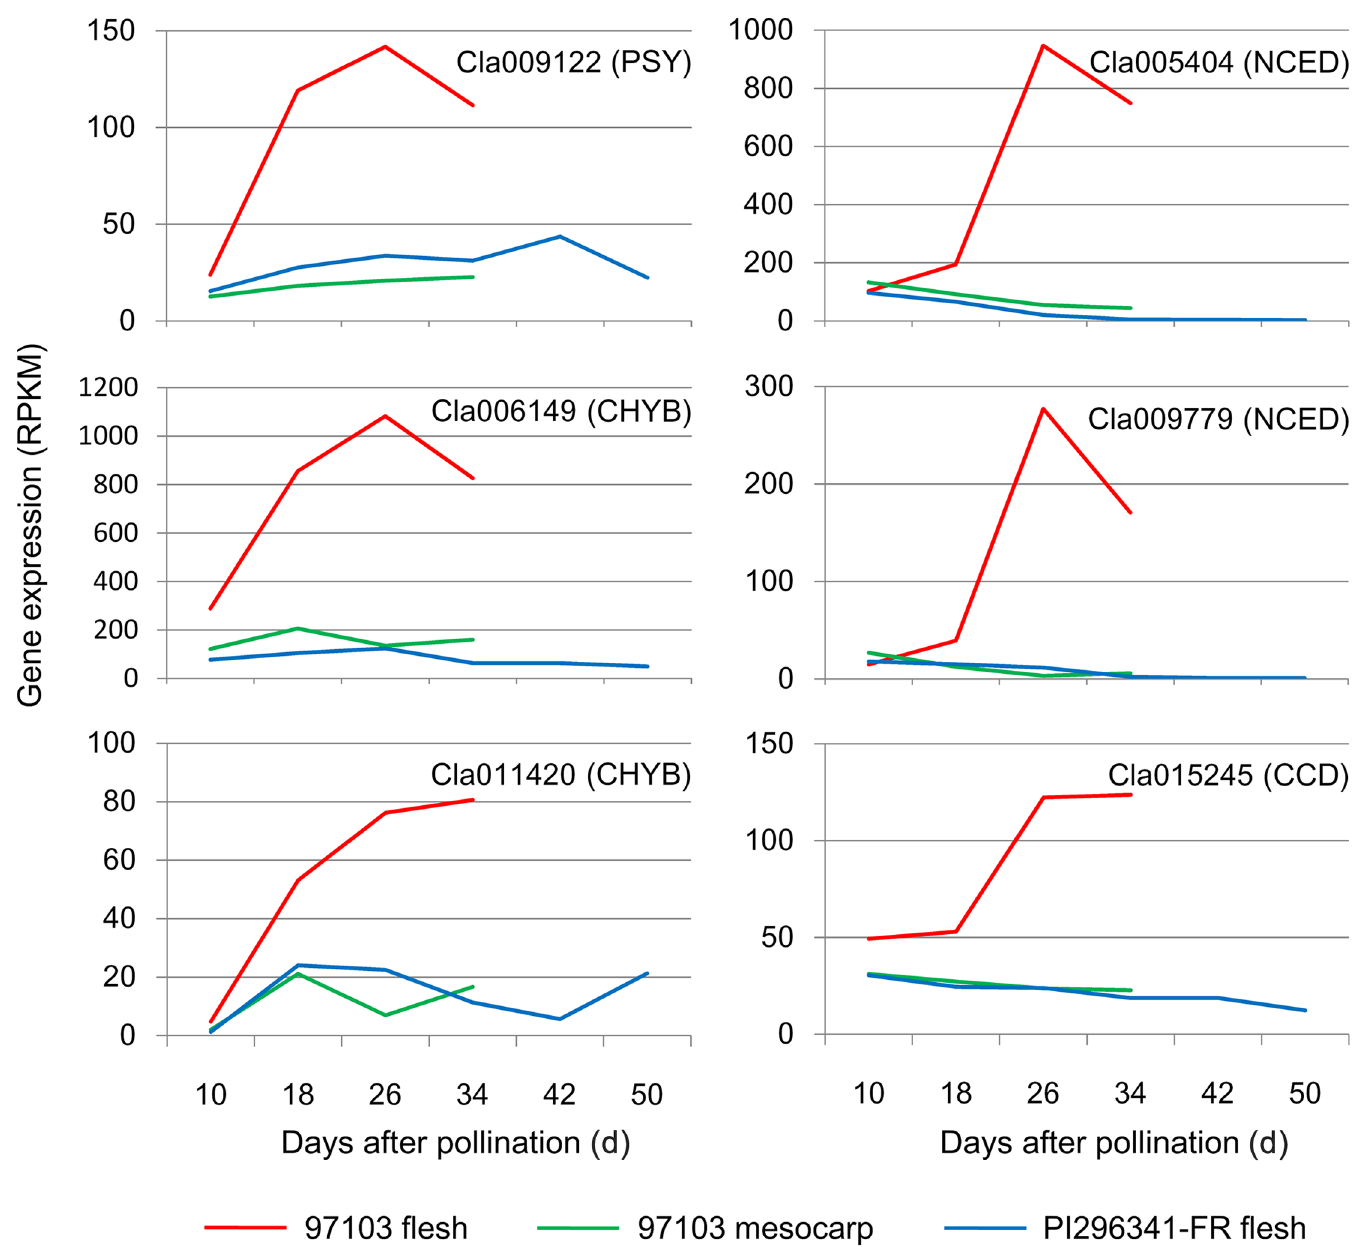
Fig 4. Expression profiles of carotenoid biosynthesis and metabolism genes during watermelon fruit development. PSY: phytoene synthase; CHYB: β -carotene hydroxylase; NCED: 9- cis -epoxy-carotenoid dioxygenase; CCD: carotenoid cleavage dioxygenase.